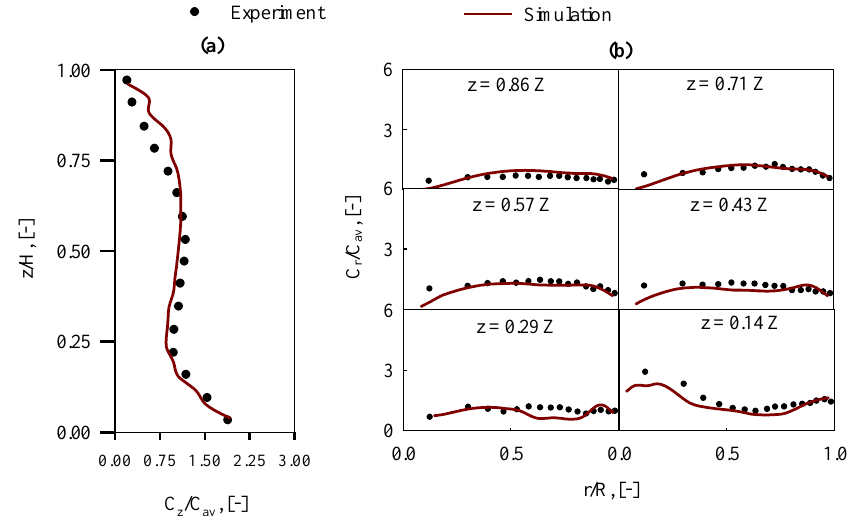
Figure 3. ( a ) Averaged axial concentration profiles and ( b ) radial concentration profiles plotted at different heights in stirred tanks with 40 wt. % solid loading using